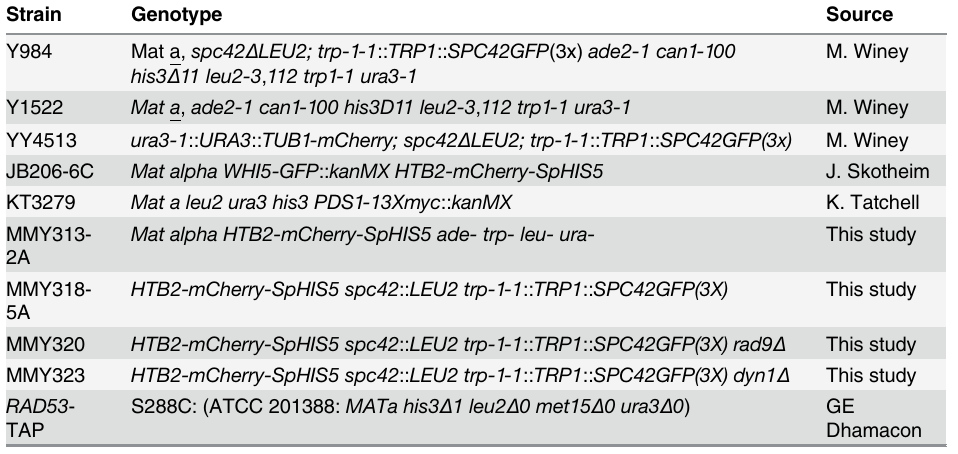
Table 1. Strains and relevant